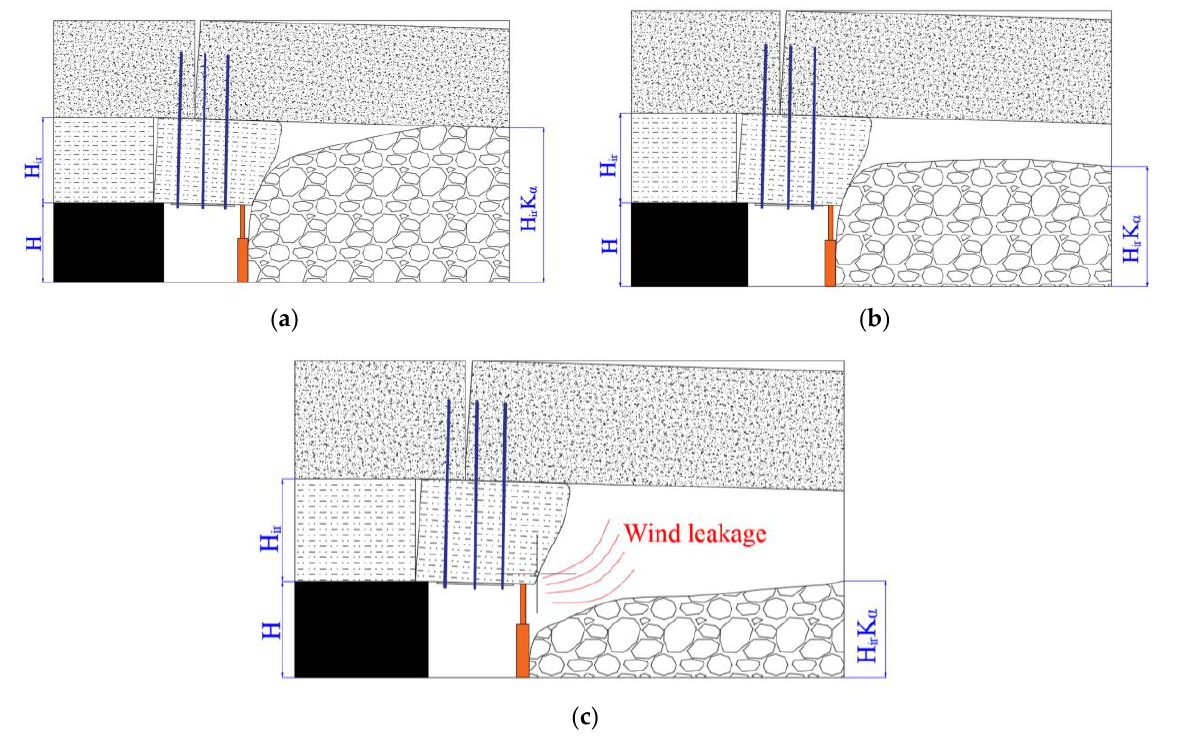
Figure 8. Determination of gangue wall formability. ( a ) The fallen gangue is higher than the coal thickness. ( b ) The fallen gangue is connected to the roof. ( c ) The fallen gangue is small in height.